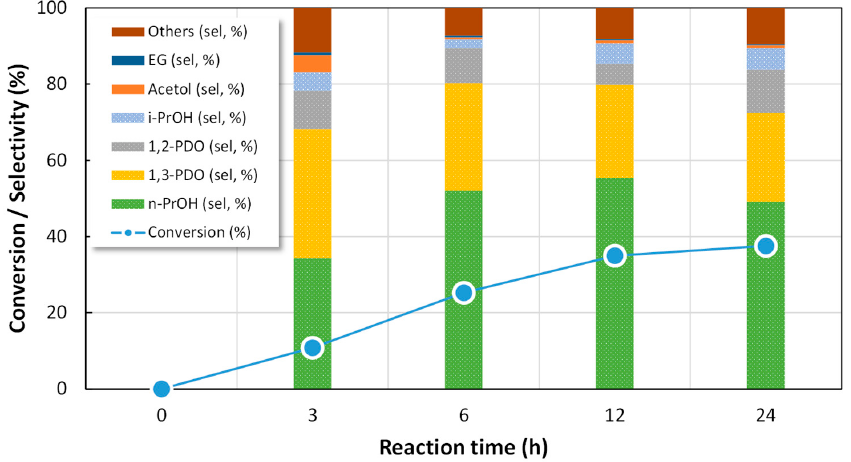
Figure 6. Reaction profile obtained in glycerol hydrogenolysis over Pt//W/ZrO 2 -200 at 180 °C, 6 bars of H 2 initial pressure, 100 mg of catalyst and 10 mL of glycerol 1.36 M.